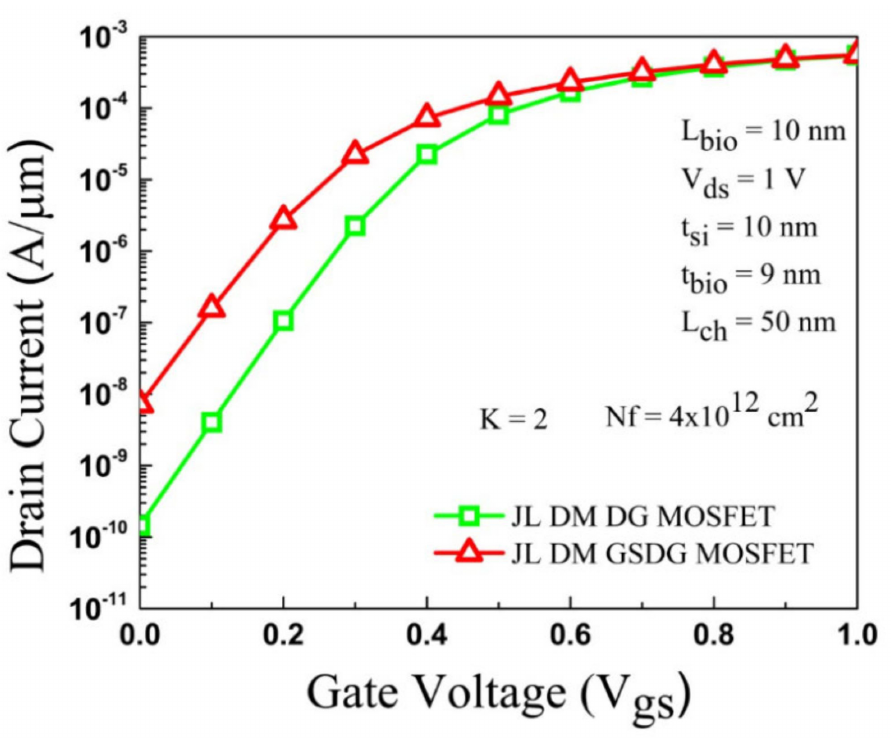
Figure 4. The I D -V gs plot of JL-DM-DG-MOSFET and JL-DM-GSDG-MOSFET for L g = 50 nm at V ds = 1V. Table 3. Performance comparison between the JL-DM-DG-MOSFET-based biosensor and the JL-DM- GSDG-MOSFET-based